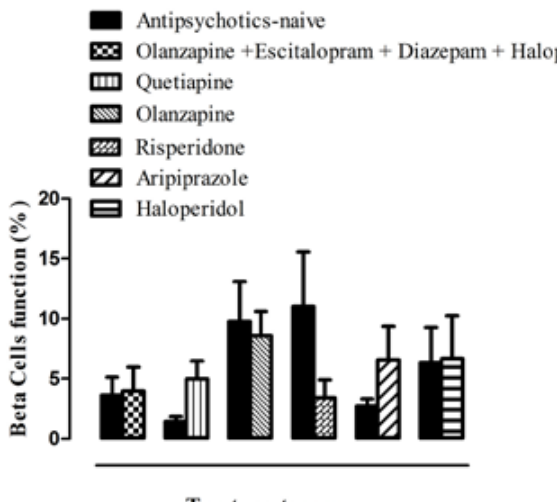
FIGURE 5 - Assessment of beta cells function (%β): Antipsychotic-naïve patients were treated with olanzapine in combination with escitalopram, diazepam (STAT, I.V) and haloperidol (STAT, I.M) (OLEDH, n=8), quetiapine (QUET, n=8), olanzapine (OLAN, n=8), risperidone (RISP, n=8), aripiprazole (n=8) or haloperidol (n=8) in therapeutic doses for an average time period of 39, 40, 45, 38, 30 and 33 days respectively showing no significant change in%β as compared to antipsychotics-naïve patients (ANOVA followed by Bonferroni’s Multiple Comparison Test) (P > 0.05).